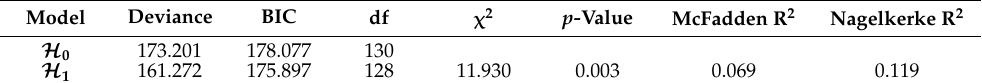
Table 10. Summary of the logistic model characterizing the relationship between the variable Y 2 : “Have you taken COVID-19 treatment?” and the variables X 2 and Z 2 (Model 4).